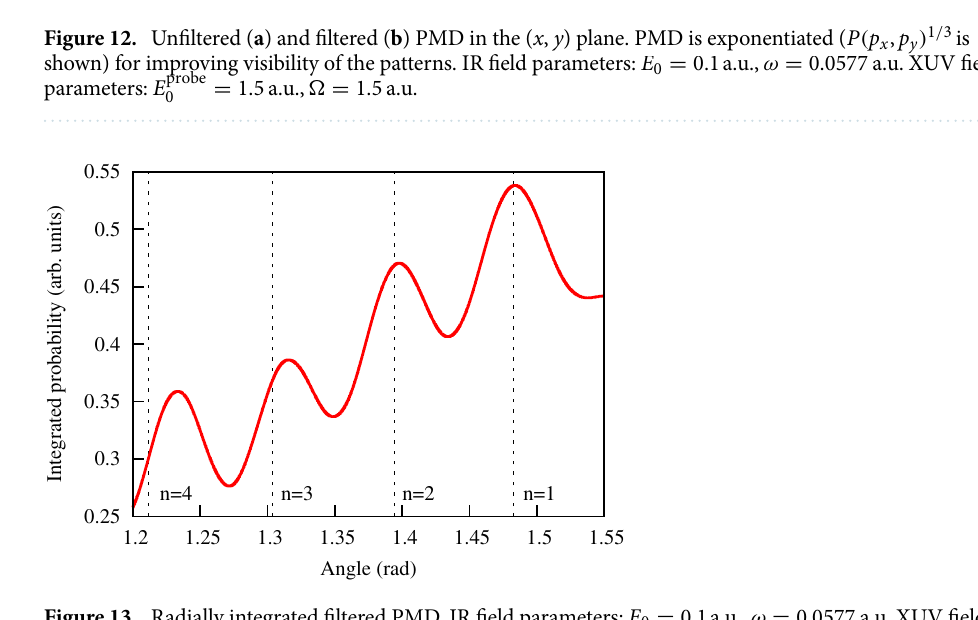
Figure 13. Radially integrated filtered PMD. IR field parameters: E 0 probe parameters: E